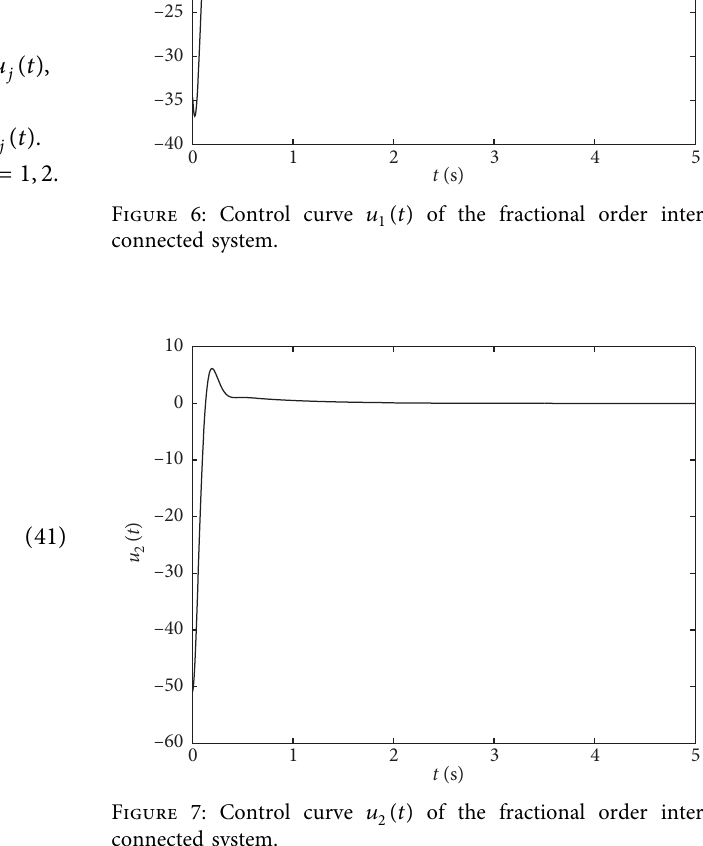
( t ) of the fractional order inter- 2